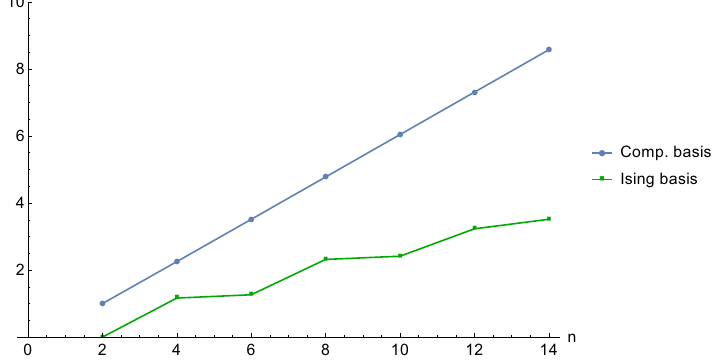
Figure 1. Shannon entropy of the critical ground state of the Heisenberg XXZ model. Computational basis in blue, Ising basis in green. Both entropies scale linearly with n